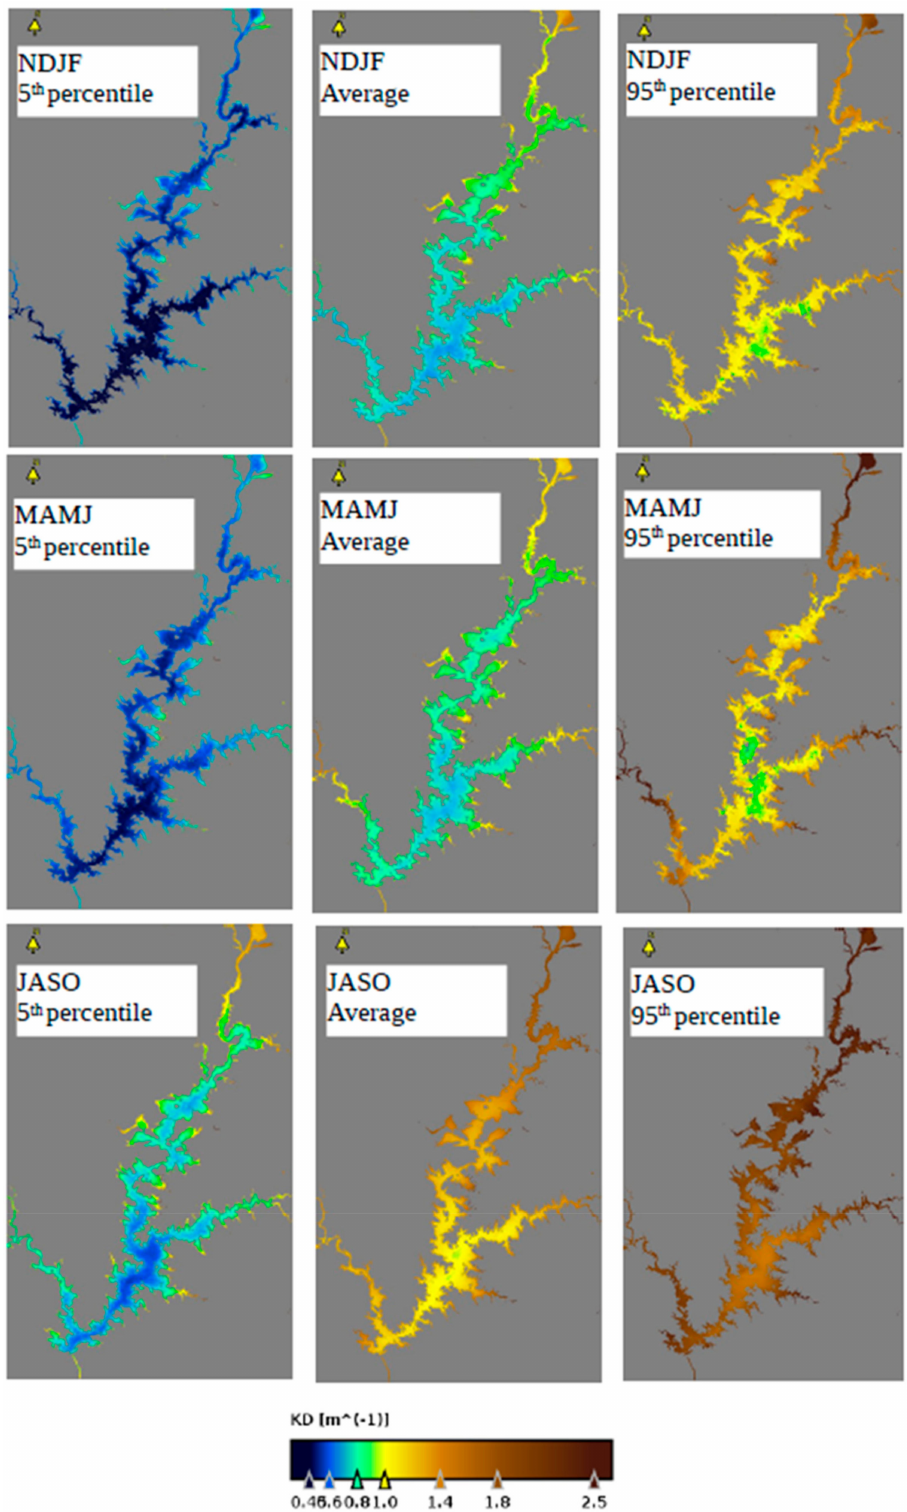
Figure 9. Same as in Figure 8 but for the di ff use attenuation coe ffi